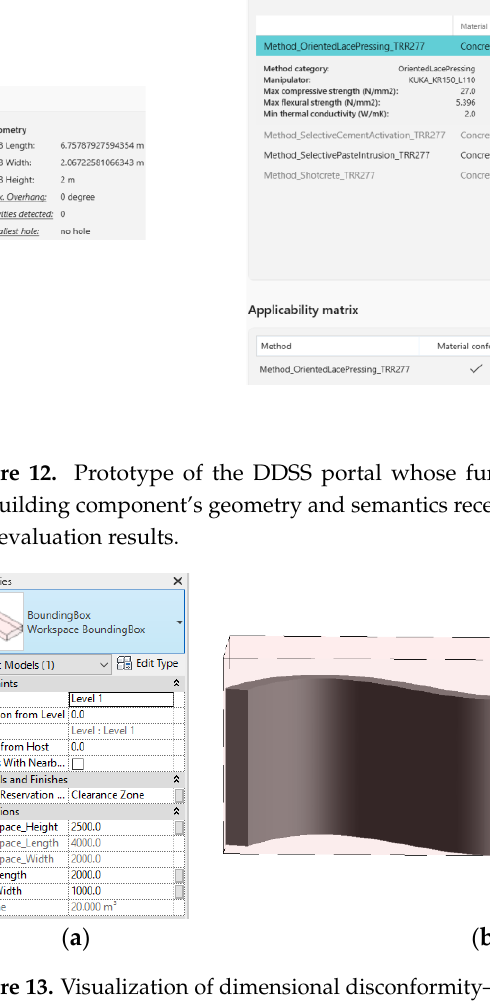
Figure 13. Visualization of dimensional disconformity — machine system ’ s workspace is smaller than the dimension of a single curved wall. ( a ) A parametric Revit family represents the workspace and is controlled by the BIM toolkit. ( b ) The workspace is automatically positioned and oriented on the curved wall.